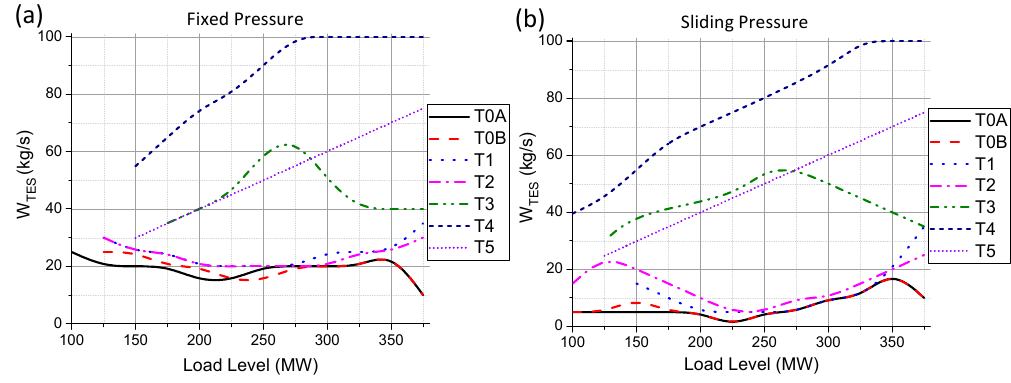
Figure 8. Maximum steam mass flow ( W TES ) to TES in FP ( a ) and SP ( b ) operating mode.